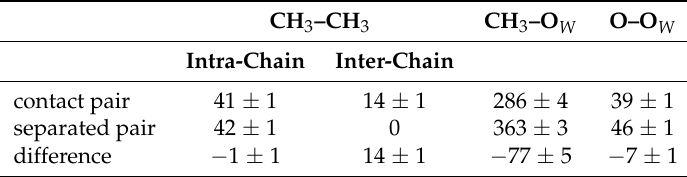
Table 4. The number of nearest-neighbors, for The L42 polymers when in contact and when separated, at 350